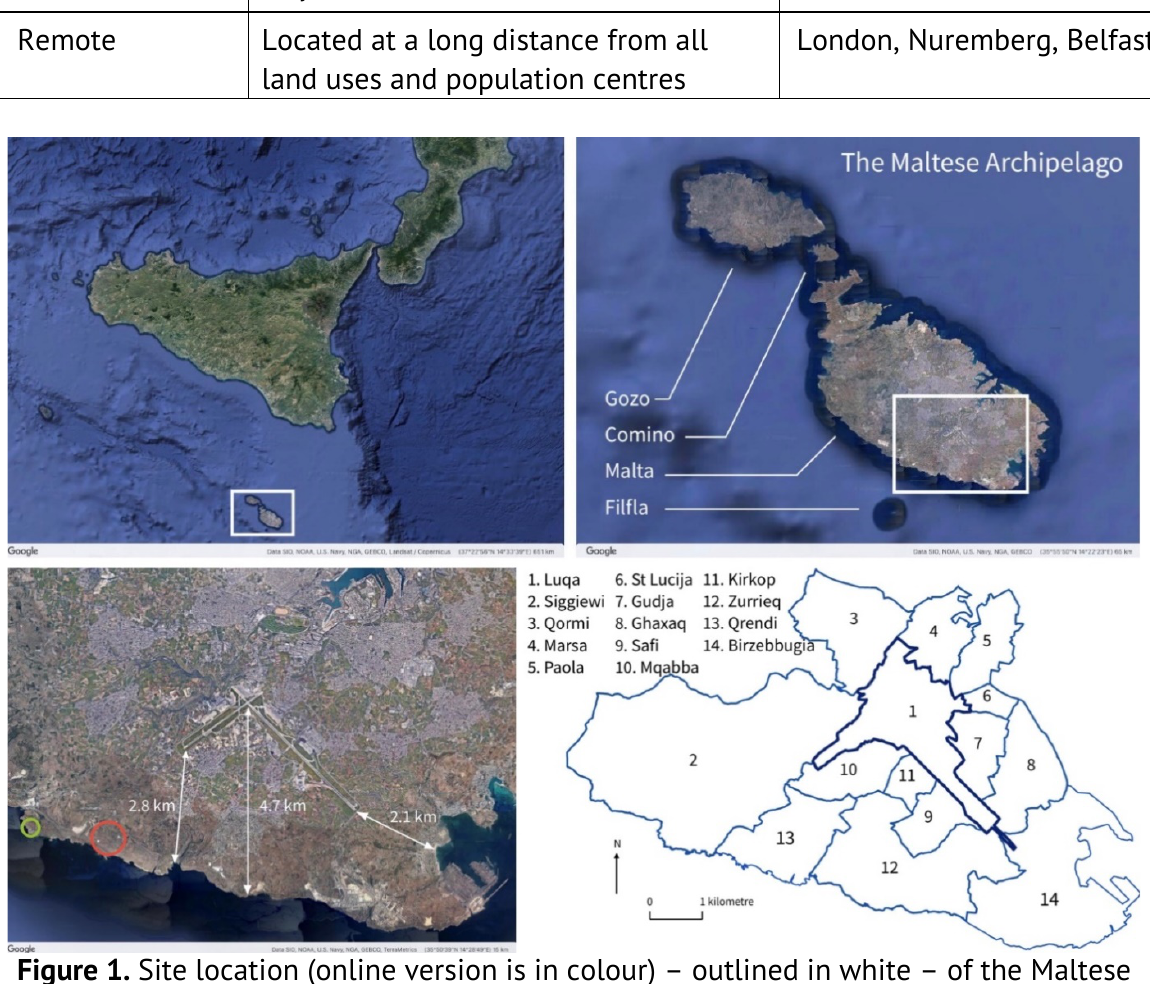
Figure 1. Site location (online version is in colour) – outlined in white – of the Maltese archipelago (top, left), Malta and its dependencies (top, right); the location of MIA with distances from the coast (bottom, left ) – Ħa ġ ar Qim and Mnajdra Neolithic Temples and Lapsi Reverse Osmosis Plant are circled in red and green respectively (© Google Earth); the administrative boundaries of various Local Councils - including Luqa (bottom, right